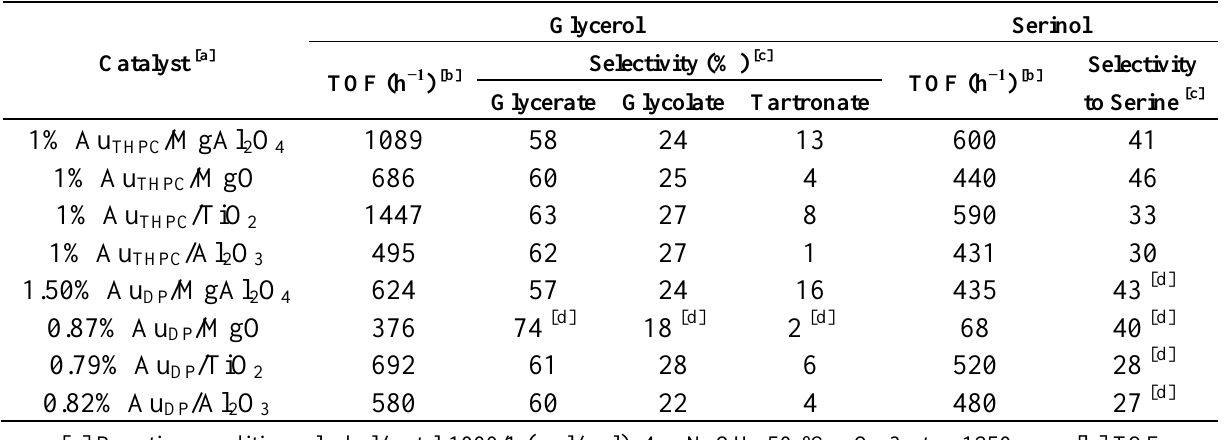
Table 2. Comparison of Au catalyst activities in glycerol and serinol oxidation.